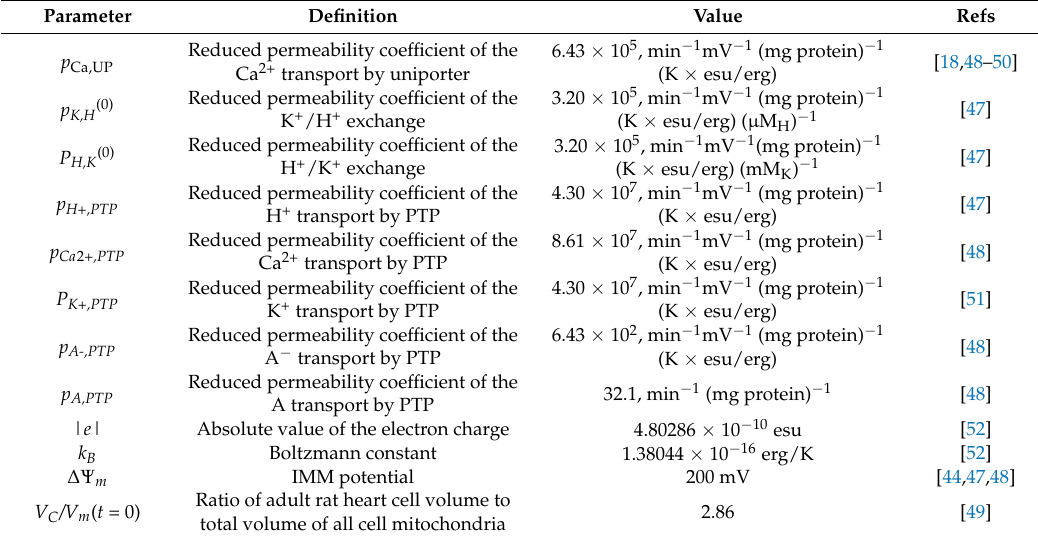
Table 1. Parameter values used in modeling